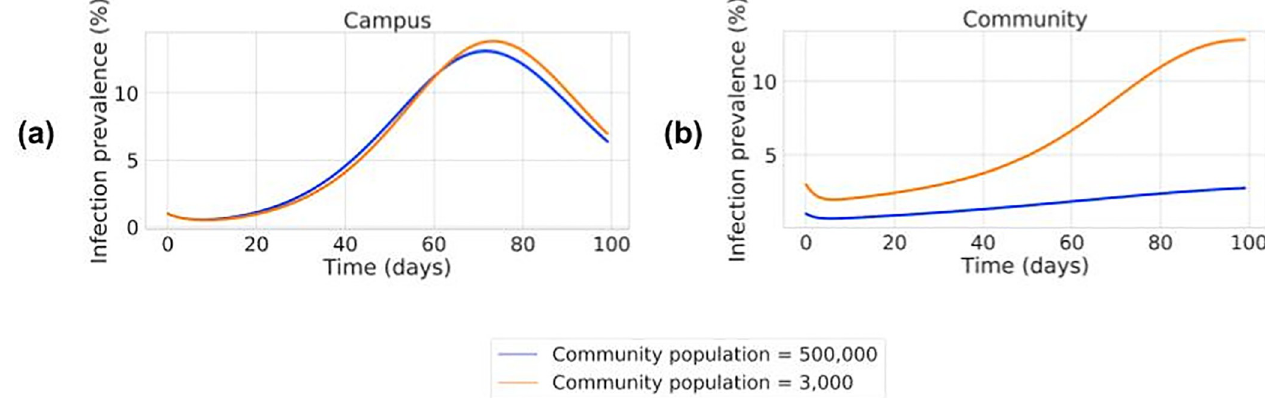
Fig 4. Impact of varying community population size on the workplace and community prevalence trajectories in a “University” setting with no asymptomatic testing. Prevalence trajectories (plotted as in Fig 2) for campus (“workplace”, panel a) and community (panel b) populations, for scenarios where initial testing and symptomatic testing are performed in the “University” (I + SYMPTOMATIC TESTING). The size of the community population here is either 500,000 (as used in all other simulations, blue curves) or 3,000 (orange curves). The campus (“workplace”) population is held constant at 1,000, as are all other simulation parameters as per S2 Table. Thus, the blue curve in panel (a) simulates the same scenario of campus prevalence for a “University” in a larger city, as in the green curve in Fig 2C.